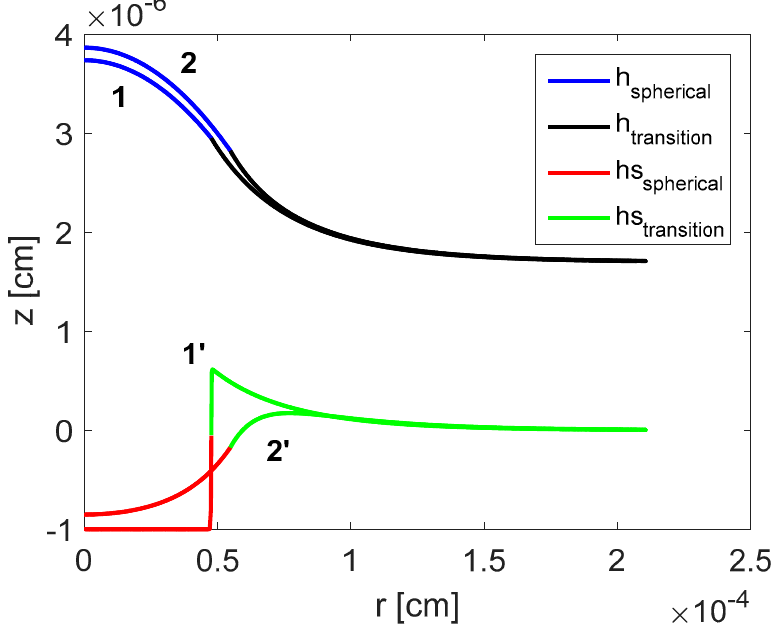
Figure 6. Computed shapes of the droplet and deformation of the substrate: 1, 1 (cid:48) − γ s = 0.001 dyne/cm and 2, 2 (cid:48) − γ s = 30 dyne/cm [18]. Reproduced with permission from [18]. Copyright © 2017 Elsevier B.V.